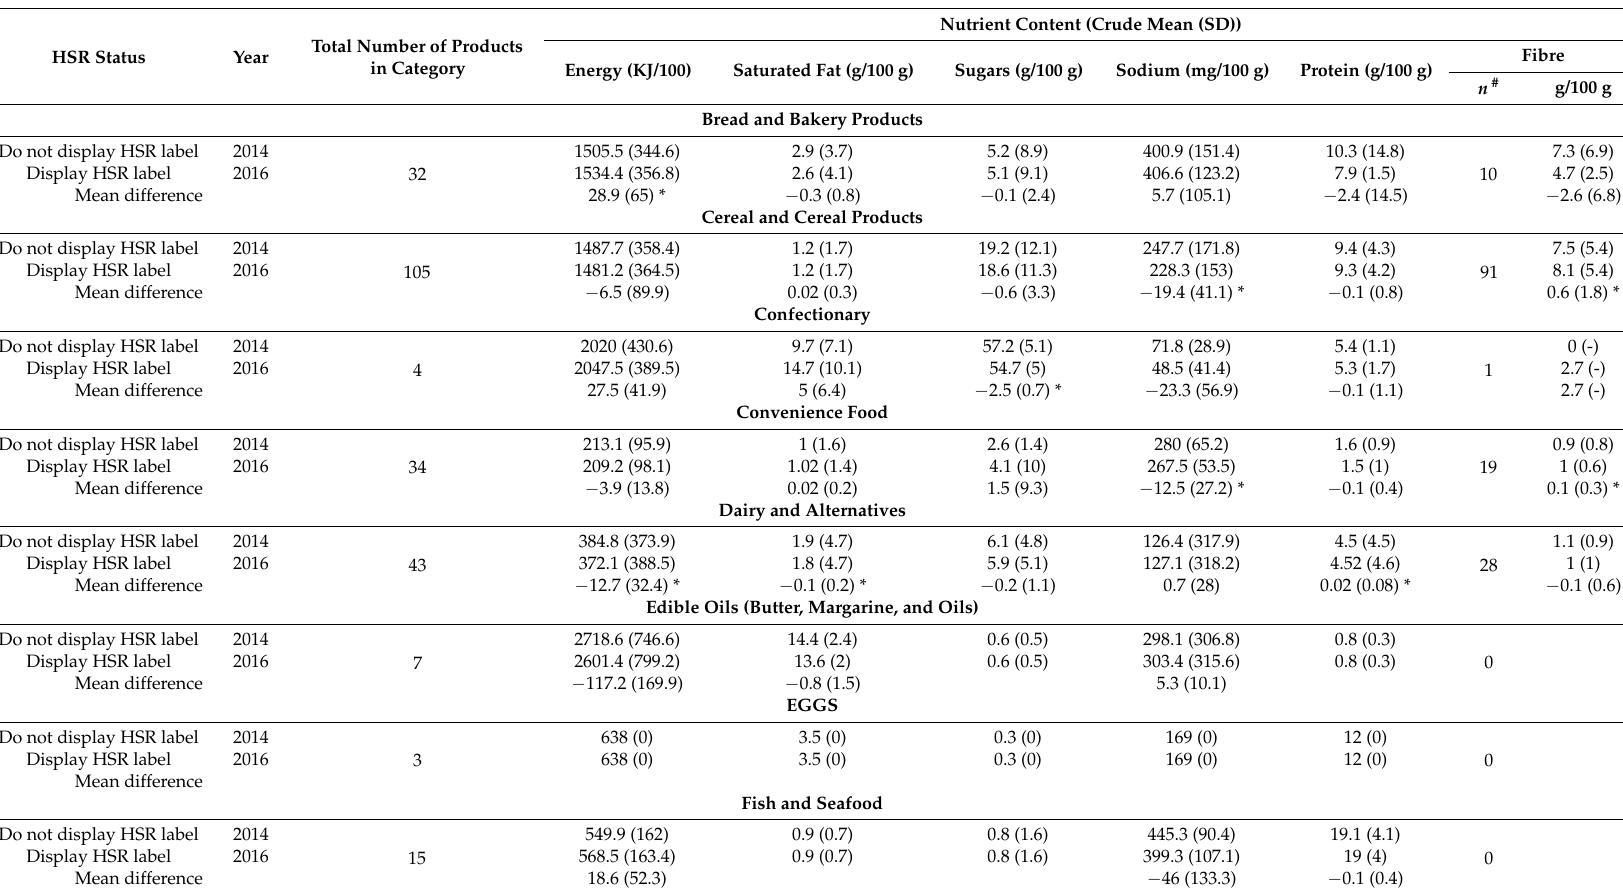
Table 3. Composition of foods displaying Health Star Ratings (HSR) in 2016 compared with composition of the same foods in 2014 (prior to introduction of HSR), by food